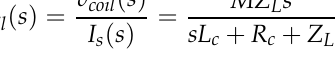
Figure 12. PCB-embedded pick-up coil equivalent circuit.